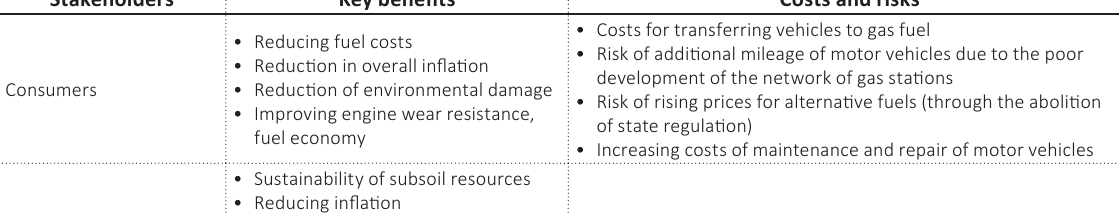
Table 1. Key benefits, costs, and risks of stakeholders in implementing a green strategy